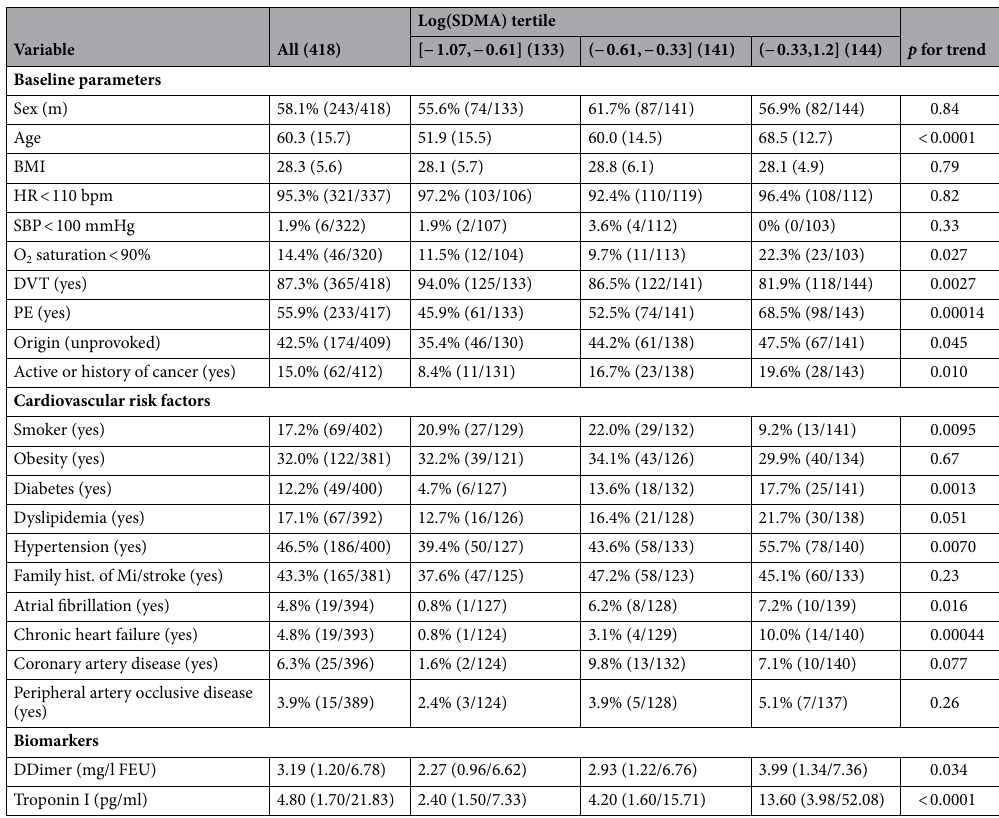
Table 4. Variables by tertiles of log(SDMA) in the cases only. BMI body mass index, HR heart rate, SBP systolic blood pressure, DVT deep vein thrombosis, PE pulmonary embolism, VTE venous thromboembolism.